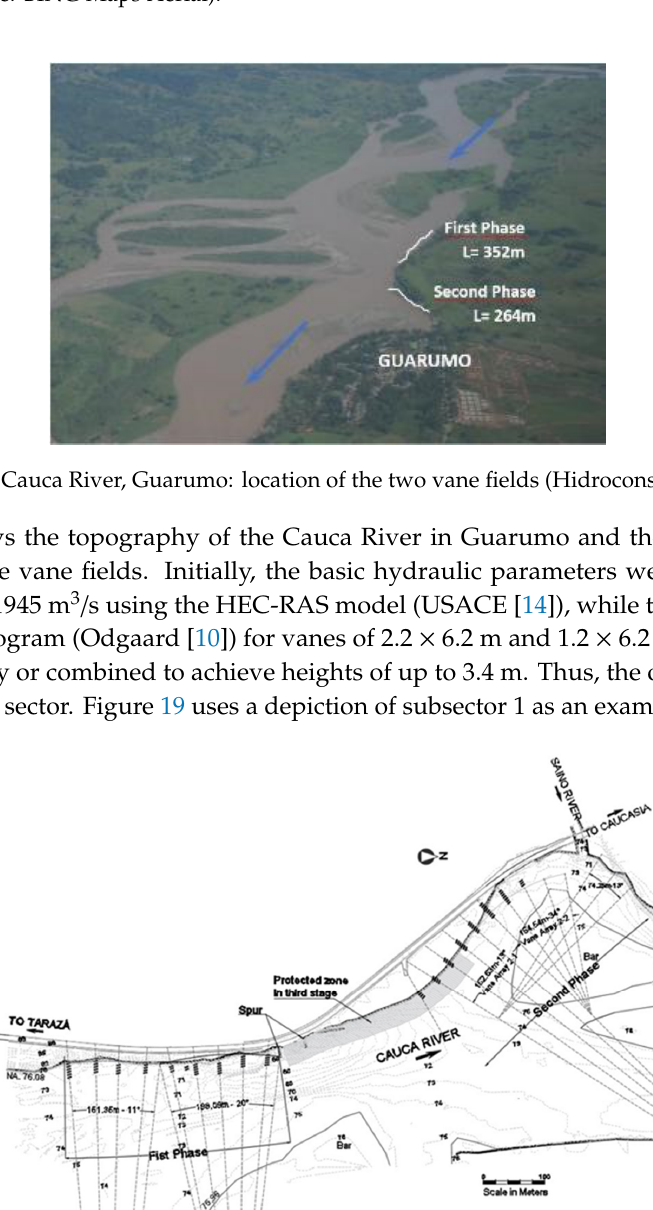
Figure 19. Cauca River, Guarumo: results of the BVANE program (Odgaard [10]) for the selection of the optimal solution with vanes using subsector 1, Stage I, as an example. The field of the first stage consisted of 41 units of vanes, distributed in nine arrays of four, five, or six units each. Each array combined vanes that were 2.2 and 1.2 m tall for heights up to 3.4 m in some cases. The second stage comprised 57 units distributed in eight arrays; in this case, panels of 1.2 × 6.2 m were combined to achieve heights of up to 2.4 m. The panels are duly supported by two metal piles that were 9.0 m in length. The first stage was completed in 95 days, from 26 December 26 2007 to 31 March 31 2008, while the second stage took 50 days, from 8 September to 25 November 2008 (Figure 20). During the development of the works, there were high flow discharges with velocities of approximately 4.0 m/s as well as changes in the direction of the current that were not present during the initial design of the panels. This presented a frontal attack on the slope between arrays 5 and 6 of the first stage, so the installation of the additional array 5A (consisting of two panels) was required.